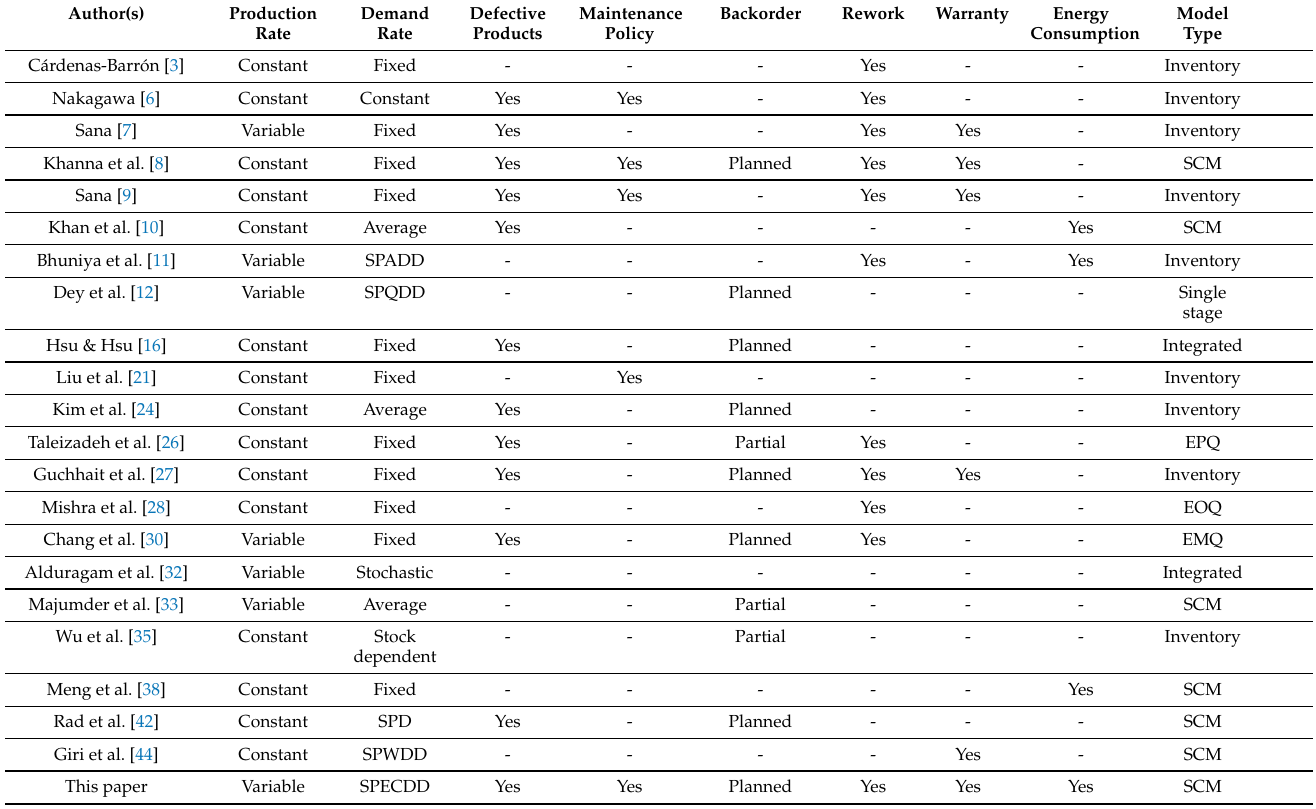
Table 1. Contribution of the previous